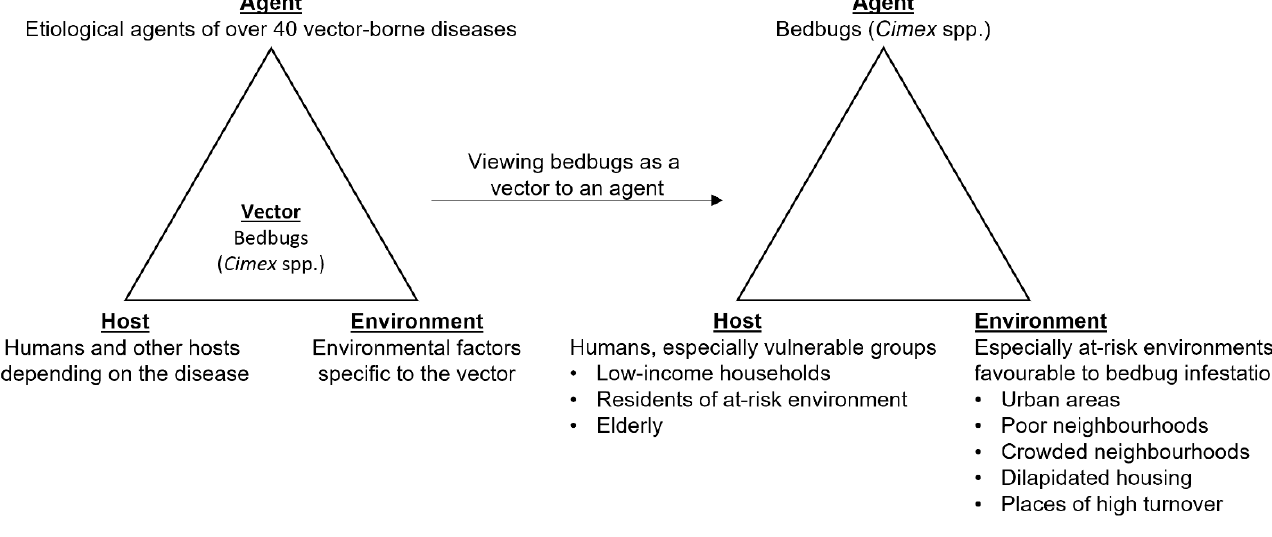
Figure 1. Shifting the view from bedbugs as a vector to an agent.